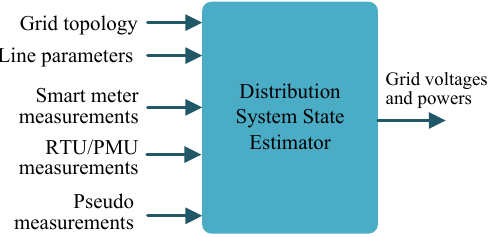
Figure 2. Block diagram of the DSSE